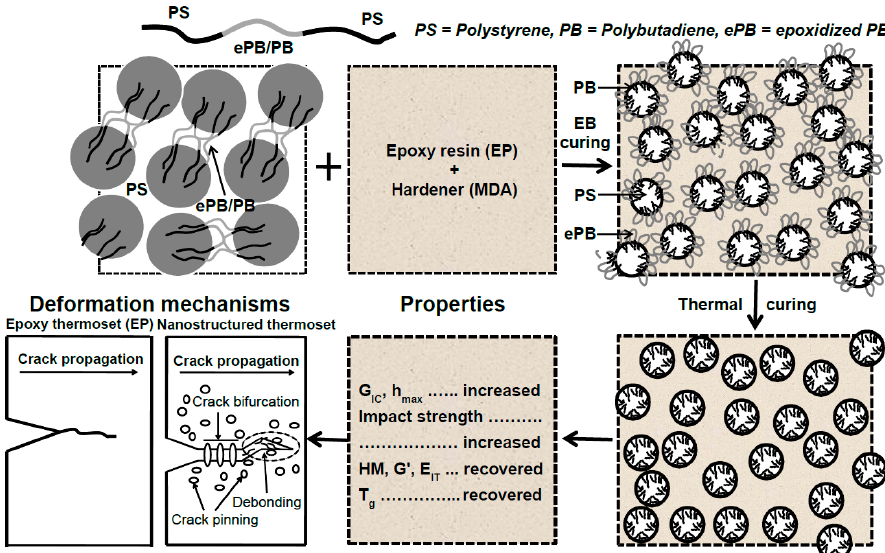
Figure 11. A schematic illustration of the formation of micro/nanodomains in the EP/eKraton blends. The ePB segments of eKraton are miscible with the epoxy system, and the PB and PS segments are immiscible with the DGEBA/MDA system. The micro- and nanostructured EP/eKraton blends are fixed by dual curing, the modulus and stiffness are recovered fractured toughness, impact strength increases, and T g values decrease. The deformation mechanism follows the crack pinning, crack bifurcation, and debonding processes.